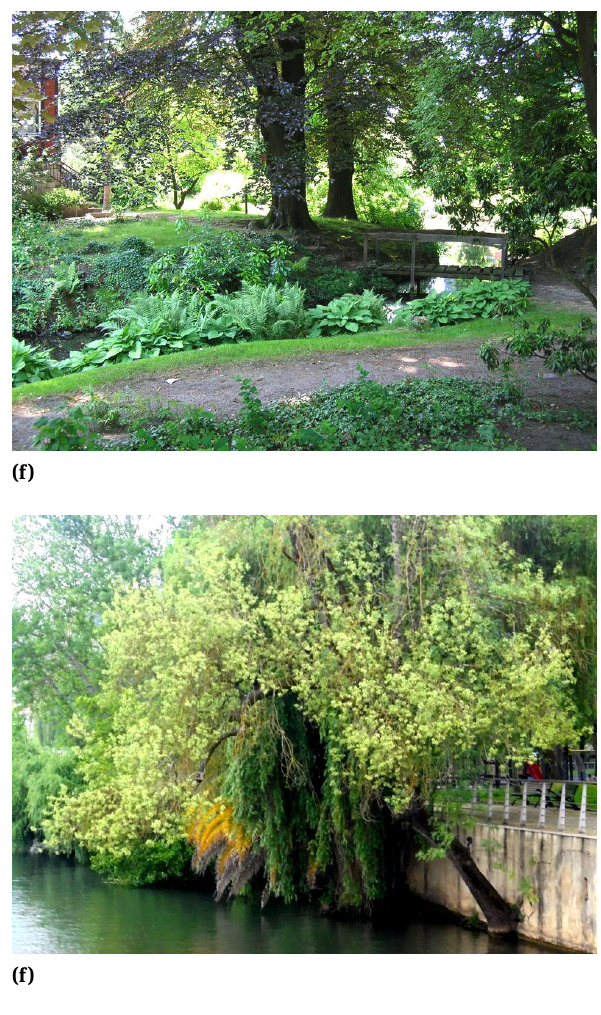
Figure 6: Back to the nature: Natural riverbanks recovered in the town Luedinghausen, Germany (f - 2006), in order to revitalize the public space in the urban environment. In Tomar, Portugal, the nature is naturally winning, since trees are in some case growing out of the concrete walls of the artificial river banks